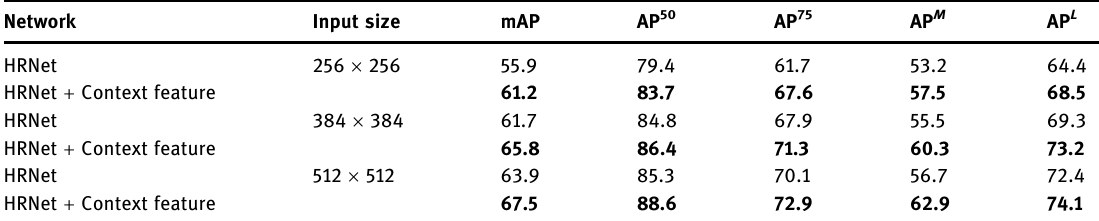
Bold values represent the best results for the corresponding metric.